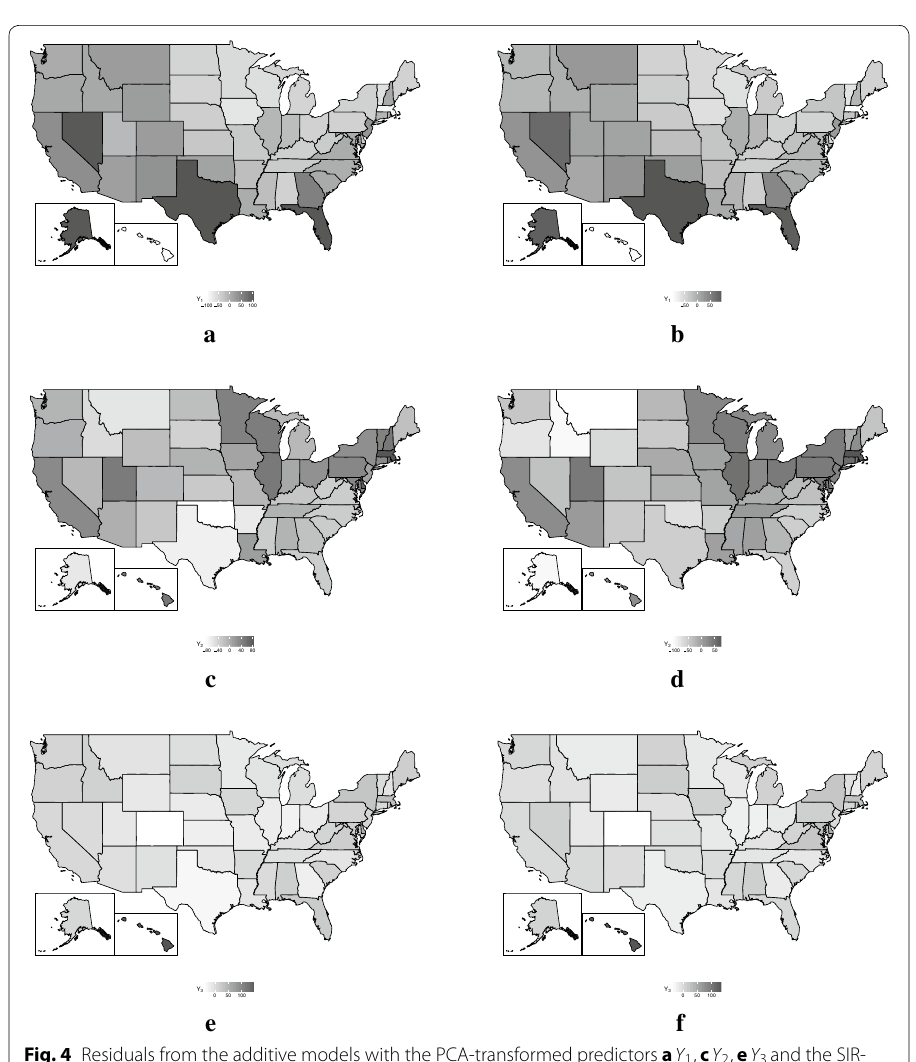
Fig. 4 Residuals from the additive models with the PCA-transformed predictors a Y 1 , c Y 2 , e Y 3 and the SIR- transformed predictors b Y 1 , d Y 2 , f Y